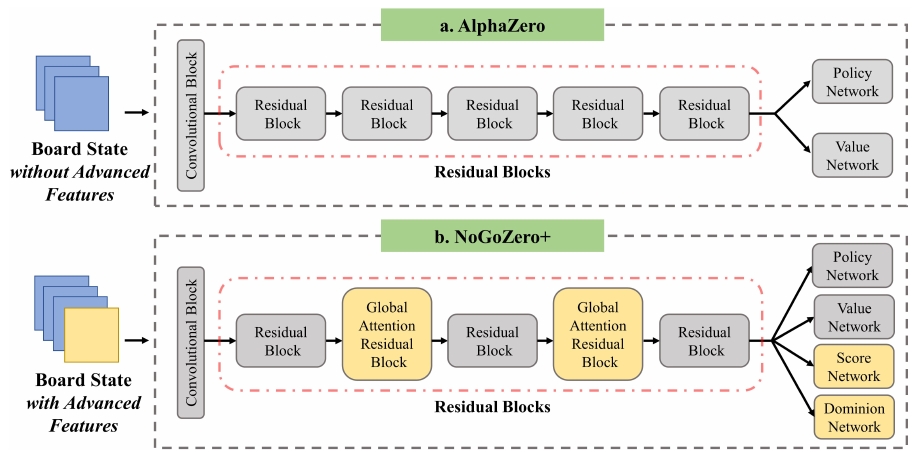
Figure 2. Comparison of network architecture of AlphaZero and NoGoZero+ (5 residual blocks).